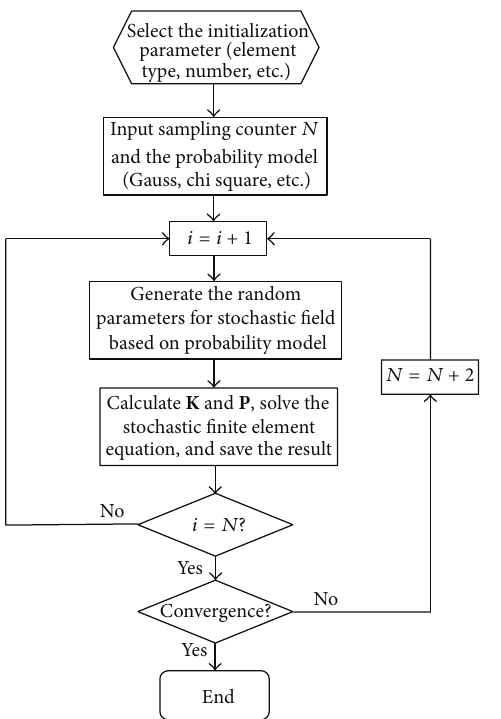
Figure 4: The flowchart of BSWI-SFEM.